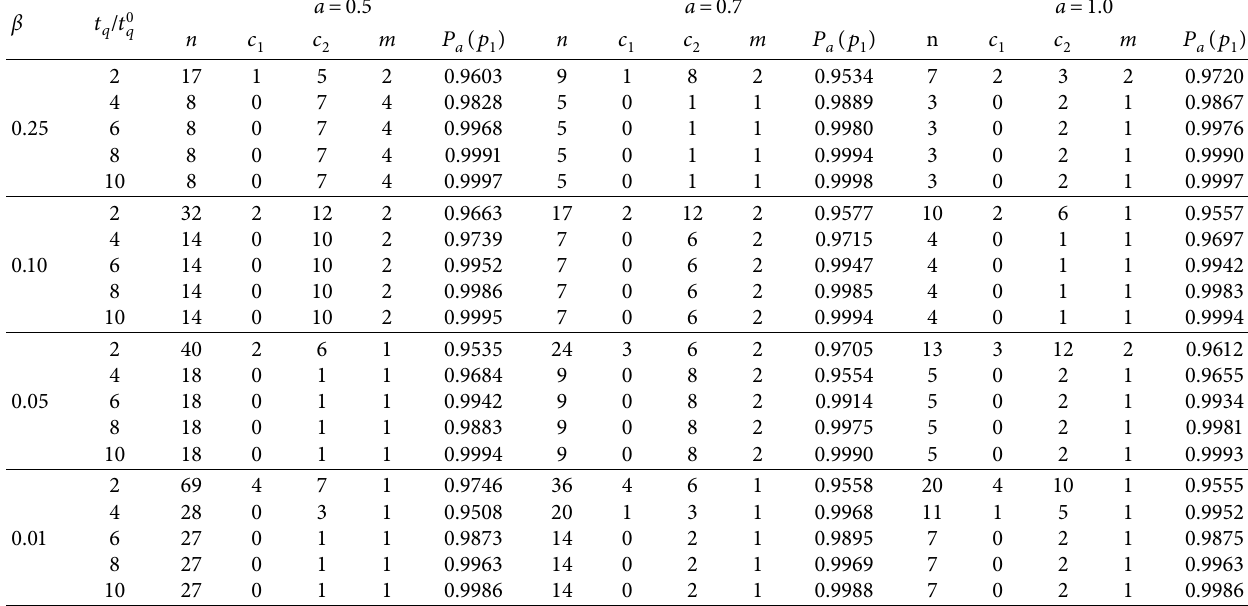
Table 3: Optimal parameters of the proposed MDSSP for EWD with δ � 1 . 5 , c � 1 . 5 at 50 th percentile.